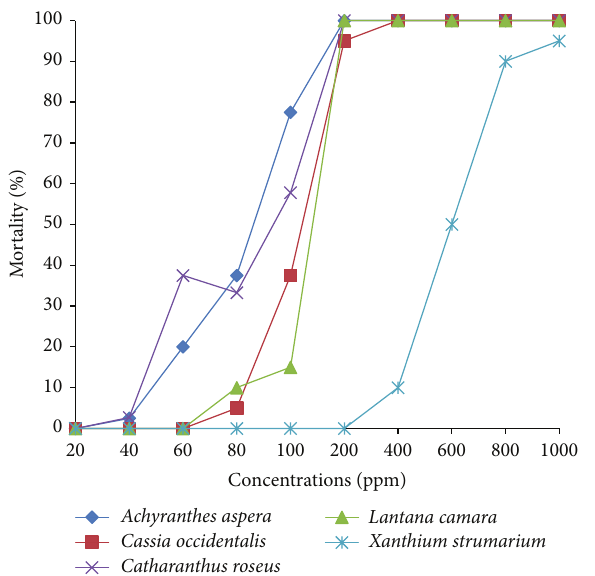
Figure 4: Comparative larvicidal activity of hexane leaf extract of different selected plants against early IV instars of Ae. aegypti .